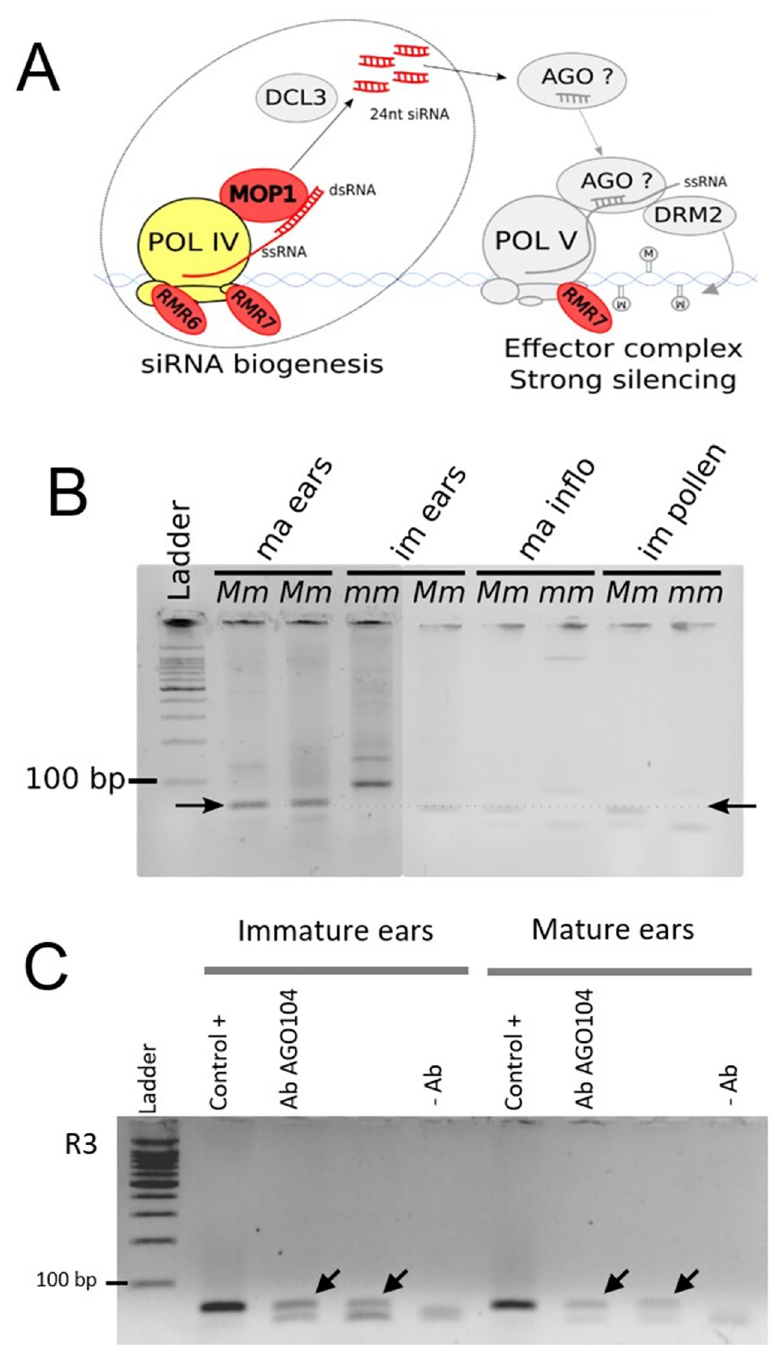
Fig 1. b1TR siRNAs and AGO104 interact in reproductive tissues. A) Identified (colored) and putative as based on homology with A . thaliana proteins (grey) RdDM members involved in small interfering RNAs biogenesis (left) and de novo DNA methylation (right) in maize. RdDM proteins involved in paramutation are shown in red. B) Stem-loop PCR for RdDM-dependent R3 siRNAs in immature (im) and mature (ma) reproductive tissues of Mm and mm B’ plants. Arrows indicate the 67-bp expected band generated by R3. Ladder: Promega 100bp DNA Ladder Molecular Weight Marker. C) Stem-loop PCR of siRNAs extracted from IPs of AGO104 performed in tissues of B’ Mop1/Mop1 plants. Control + are small RNAs extracted directly from reproductive tissues. AbAGO104 are small RNAs extracted from the IPs of AGO104. -Ab correspond to the mock immunoprecipitation samples (without Ab). Arrows indicate the 67-bp expected bands. Ladder: Promega 100bp DNA Ladder Molecular Weight